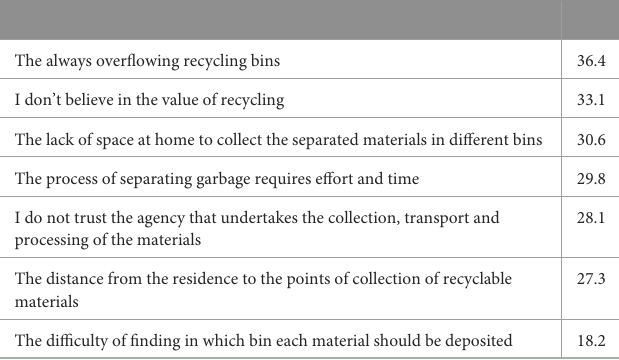
TABLE 2 Reasons for the discouragement of recycling in percentage ( N =